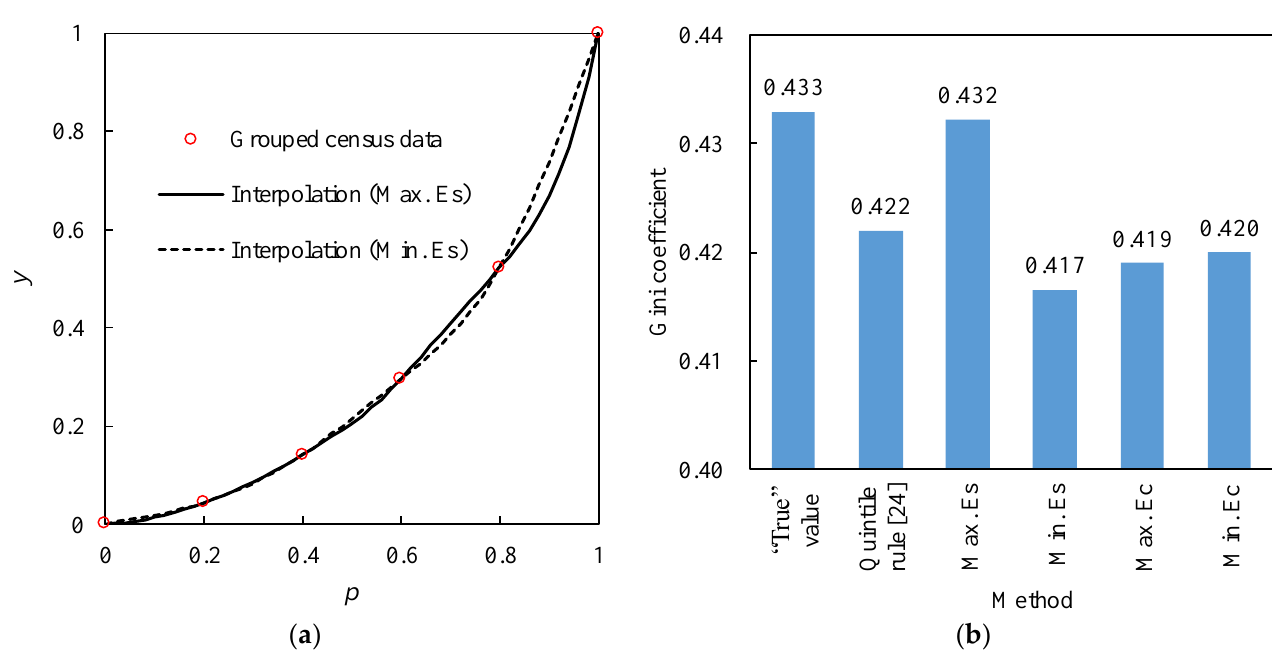
Figure 3. ( a ) Grouped quintiles of US income census data in 2000 [24] and interpolated Lorenz curves based on maximization (Max. Es) or minimization (Min. Es) of approximated strain energy; ( b ) Comparison of Gini coefficients estimated with different methods.